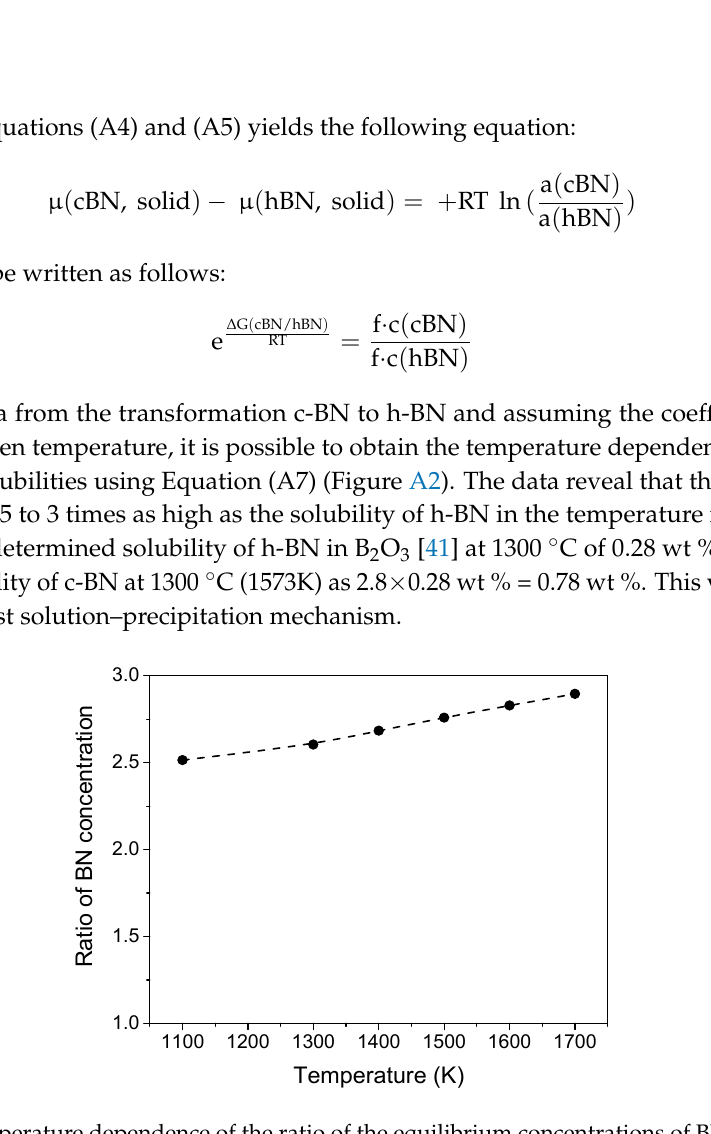
Figure A2. Temperature dependence of the ratio of the equilibrium concentrations of BN in the melt over c-BN and h-BN calculated based on Equation (A7) and Δ G° (cBN/hBN) (see Figure A1). The ratio of equilibrium saturation concentrations of c-BN and h-BN in the liquid is directly connected with the change in the Gibbs free energy ( Δ G°) of the reaction for conversion of c-BN to h-BN at the given temperature. The ratio decreases with decreasing difference in the Gibbs free energy and becomes 1 if c-BN stops being the metastable phase (at 298 K in the present calculations). The chemical potential also depends on the grain size. Very fine-grained h-BN particles compensate at least partially for the differences in the chemical potential. Therefore, a critical h-BN size of nucleus is necessary for the transformation.